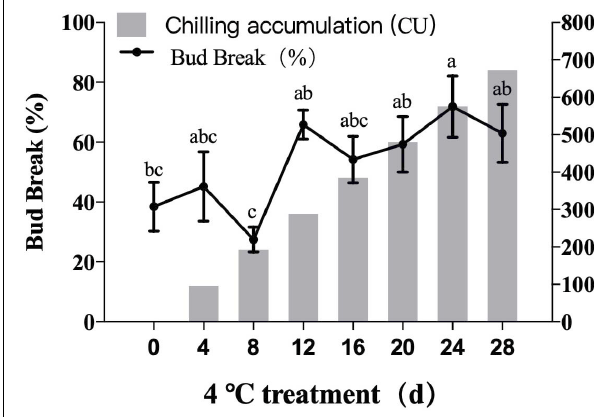
FIGURE 8 | Germination rates of blueberry flower bud under different cold accumulation. All were the highest germination rates.